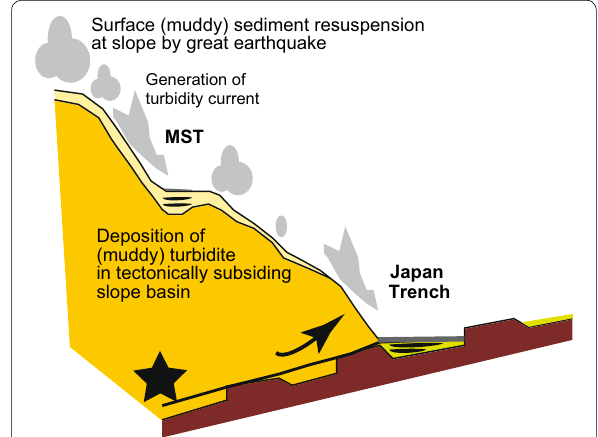
Fig. 4 Schematic diagram of the sedimentary processes of a small MST